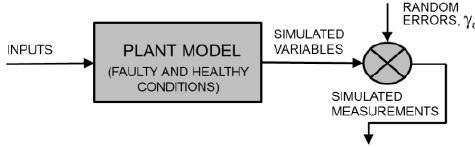
Figure 4. Replacement of the real FC plant and related sensors (see Figures 1–3) by a plant model, which simulates healthy and faulty conditions and whose output variables are subject to random errors.